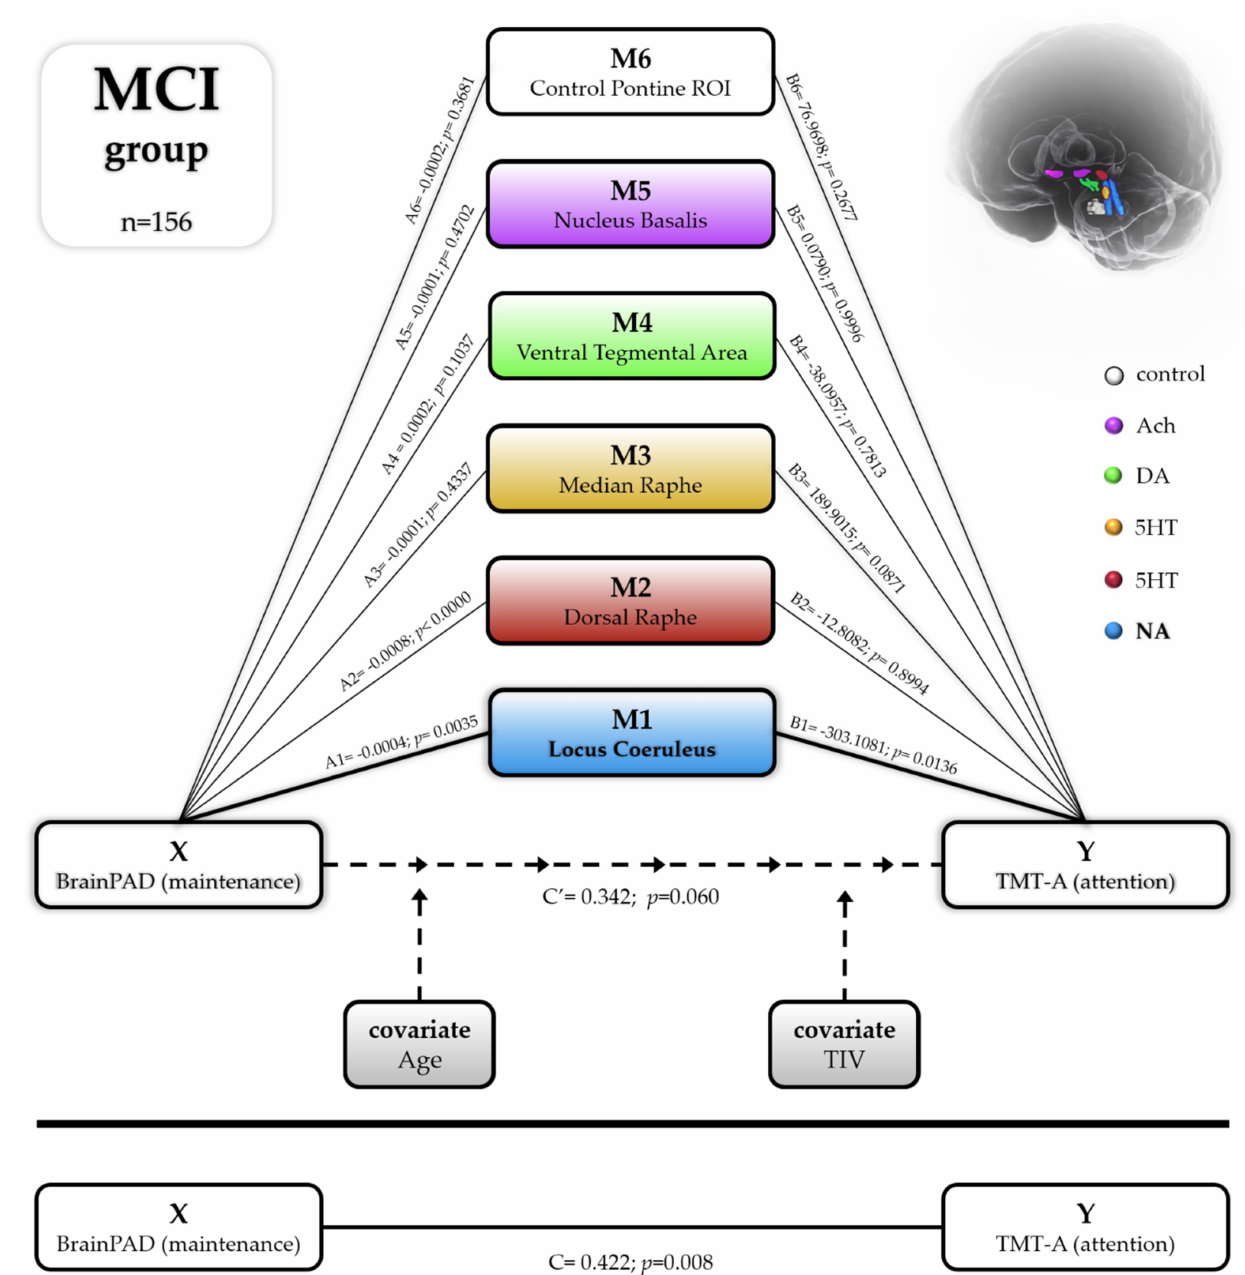
Figure 5. Statistical diagram of the parallel mediation model (model n.4) testing the relation between BrainPAD (biological measure of brain maintenance) and TMT-A (attentional visuo-motor speed processing) in MCI group (n = 156). The average volumes of the six ROIs were treated as parallel mediators in order to test the noradrenergic theory of cognitive reserve versus the other main neuromodulator’s seeds: serotoninergic (Dorsal and Median Raphe), dopaminergic (Ventral Tegmental Area), cholinergic (Nucleus Basalis of Meynert) and additionally with a brainstem control region neuromodulator-free (control pontine ROI). In the MCI group, the only significant mediator of the relation between brain maintenance and cognitive performance was the volume of the LC (Noradrenaline); all the other five ROIs were not significant in mediating the relationship. The model was covaried for age and total intracranial volume